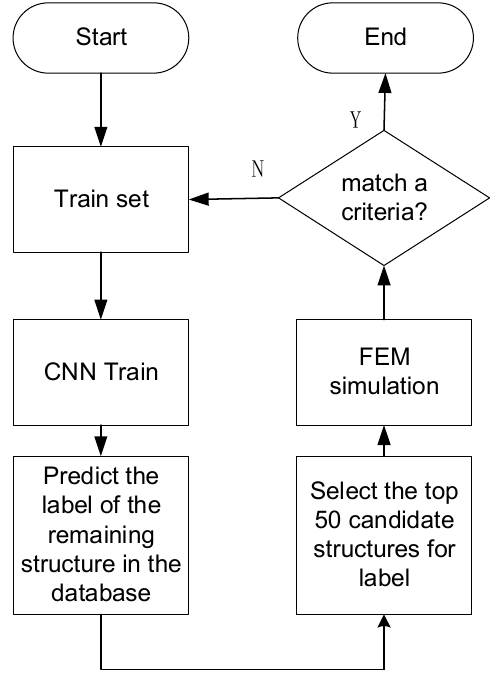
Figure 10. Flowchart of CNN ‐ based search method.